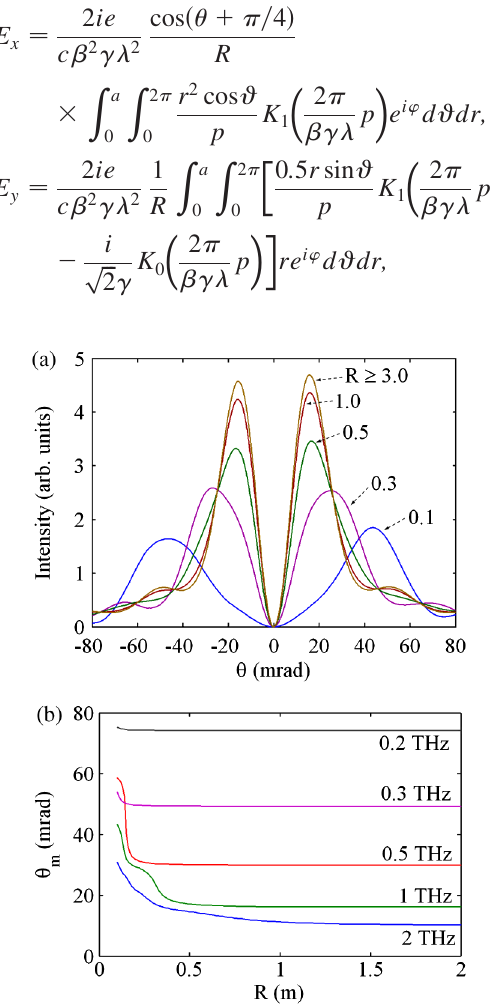
FIG. 4. (cid:7) and (cid:8) cross sections of distribution in Fig. 3, inten- sity distribution of transition radiation from single electron, and intensity distribution of transition radiation from the uniform electron beam with radius of 1.2 mm, which is similar to the beam size in Fig. 3.